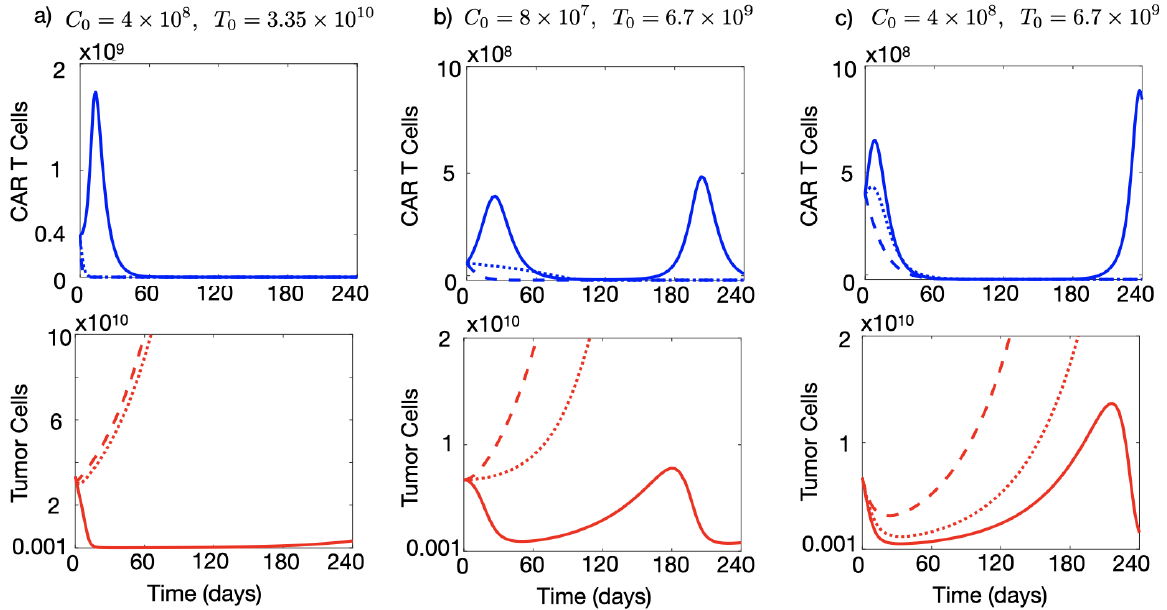
Figure 4. Simulated tumour and CAR-T dynamics under different initial conditions for the number of injected cells and initial tumour load. Dynamics of the number of CAR-T cells (blue curves) and tumour cells (red curves) governed by Equations (1) and (2) in three different scenarios of immune suppression: α 1 = 0.04 day − 1 (solid lines), α 1 = 0.07 day − 1 (dotted lines) and α 1 = 0.1 day − 1 (dashed lines). Parameter values used in the simulations τ C = 7 days, ρ C = 0.9 day − 1 , ρ T = 1/50 day − 1 , α 2 = 2.5 × 10 − 10 day − 1 cell − 1 , g T = 10 10 and g C = 2 × 10 9